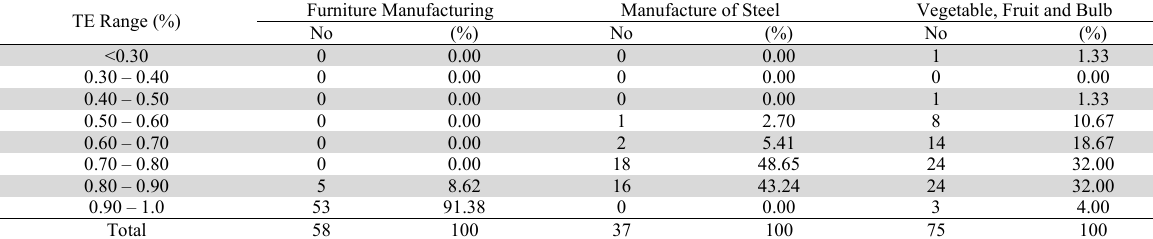
Frequency Distribution of Technical Efficiency Level TE Range (%)